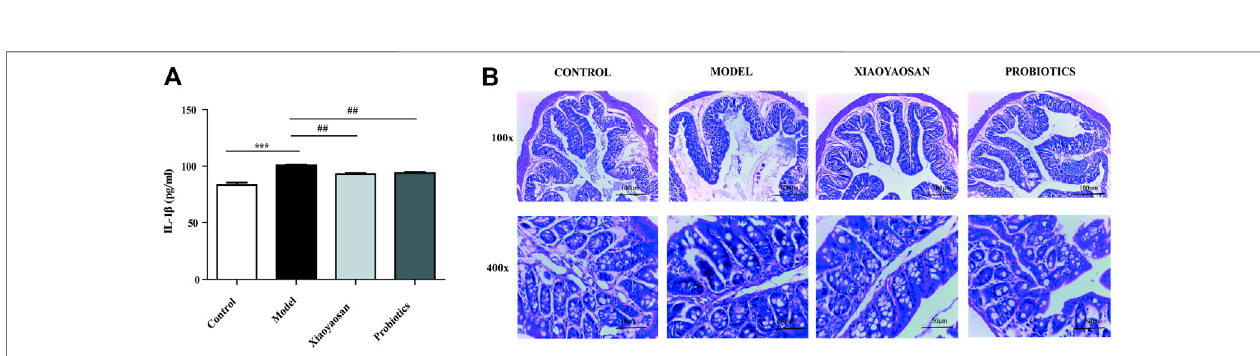
FIGURE 4 | Effects of Xiaoyaosan on IL-1 β and Effect of Xiaoyaosan on Colon Pathology. (A) The IL-1 β Level of Serum. (B) Effect of Xiaoyaosan on Colon Pathology. Hematoxylin and eosin staining of the colon ( × 100magni fi cation, × 400magni fi cation).